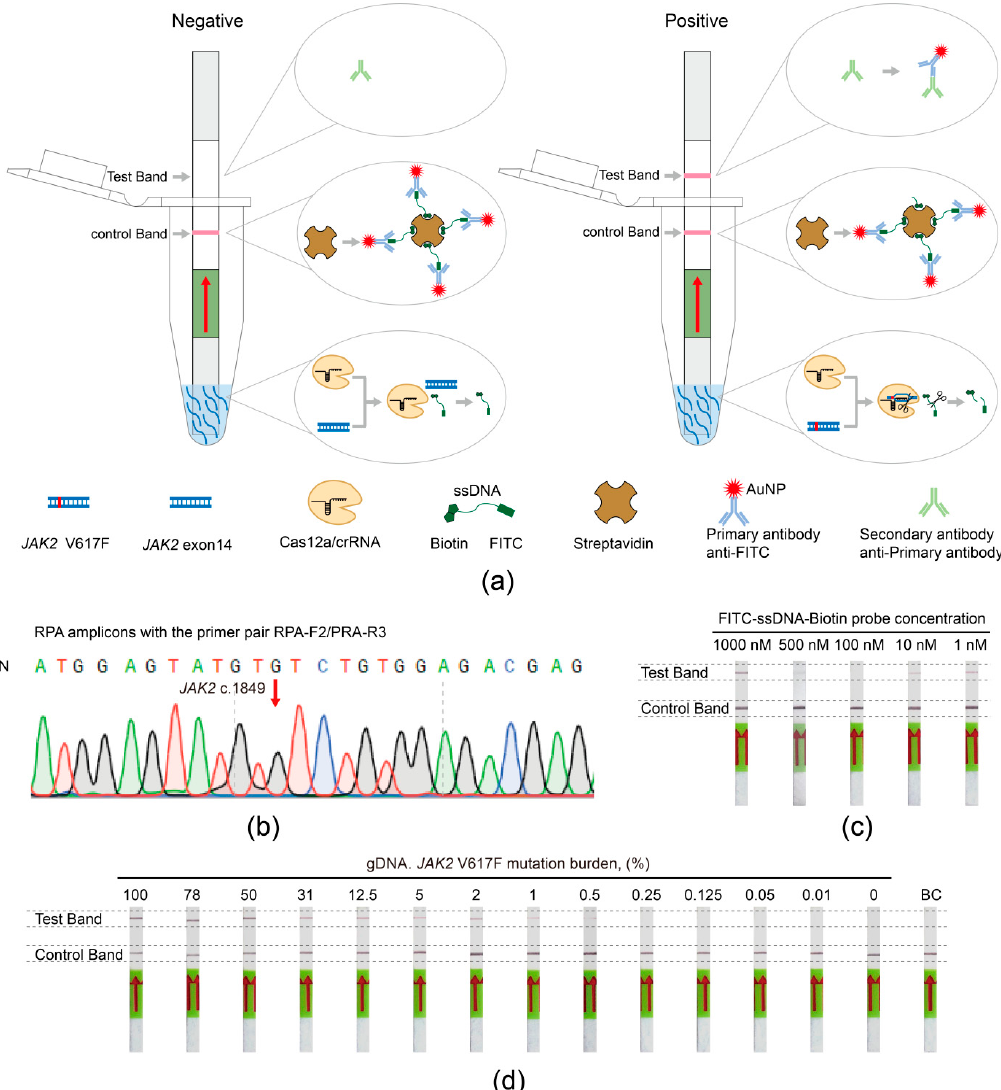
Figure 4. The JAK2 V617F/Cas12a lateral flow strip assay. ( a ) Schematic illustration of the JAK2 V617F/Cas12a lateral flow strip assay. ( b ) Sequencing results of Recombinase Polymerase Amplification (RPA) products amplified with the primer pair RPA-F2/RPA-R3. N, healthy donor. ( c ) Optimizing the amount of FITC–ssDNA–Biotin probe. ( d ) Sensitivity of the JAK2 V617F/Cas12a lateral flow strip assay. The concentration of gDNA in each sample was 100 ng/ µ L. An equal volume of nuclease-free water was used as blank